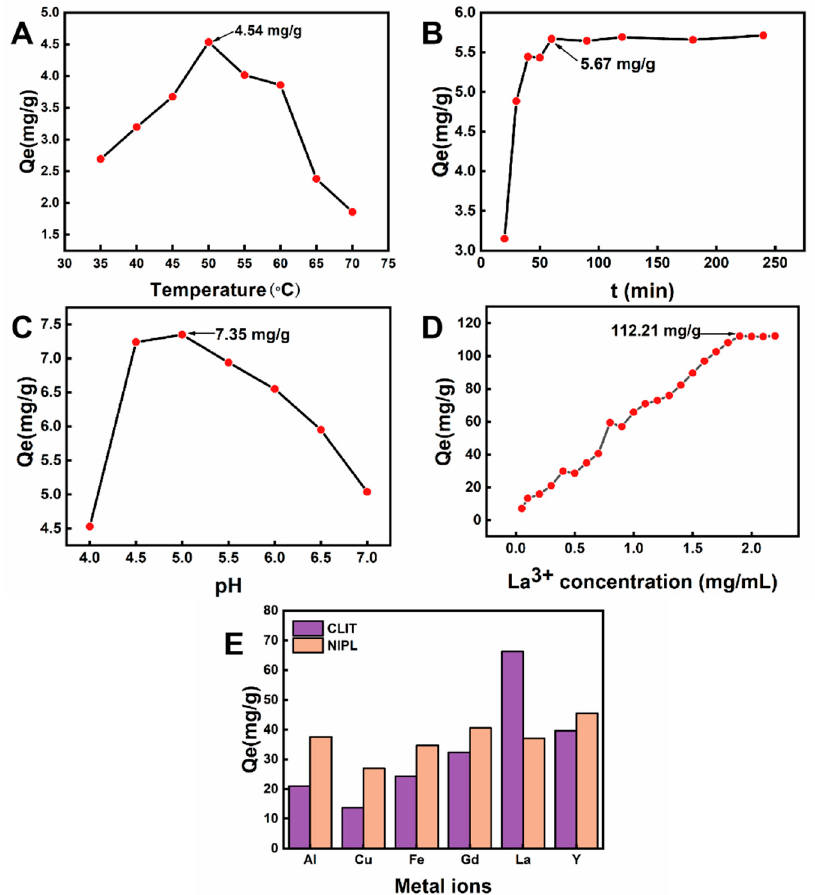
Figure 5. The effects of temperature ( A ), adsorption time ( B ), the pH value of the adsorption solution ( C ), the initial La 3+ concentration ( D ) on the adsorption capacity of CLIT; ( E ) The adsorption capacity of CLIT and NIPL to metal ions coexisting in the same solution (containing Al 3+ , Cu 2+ , Fe 3+ , Gd 3+ , La 3+ and Y 3+ ).